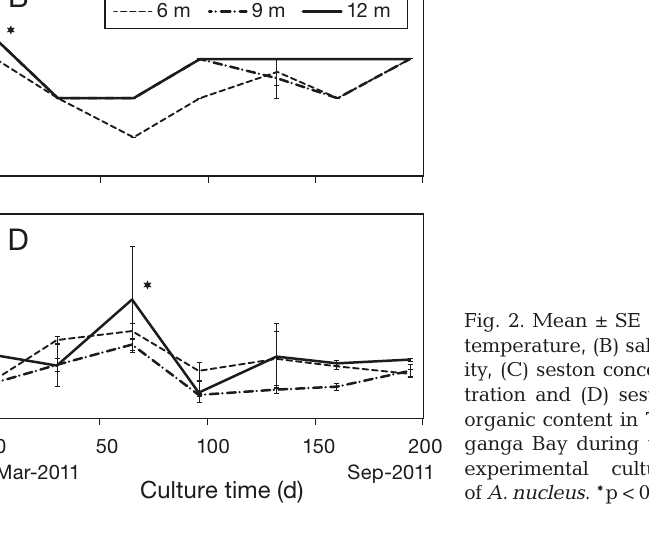
ative correlations were found between the monthly growth rates of A. nucleus and water temperature (Table 3). The frequency of presence of cymatid snails in the pearl nets oscillated between 0 and 16 ind. m −2 , their shell lengths fluctuated between 3 and 28 mm (Fig. 3A), and their growth rates ranged between 0